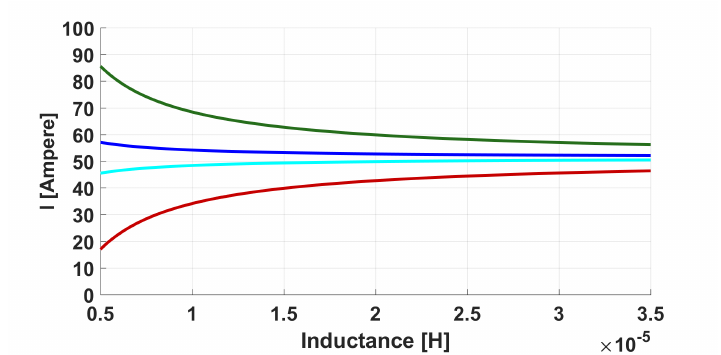
Figure 6. Inductor current during buck mode. I peak with V grid = 50 V (green curve), I peak with V grid = 40 V (blue curve), I min with V grid = 50 V (red curve) and I min with V grid = 40 V (cyan